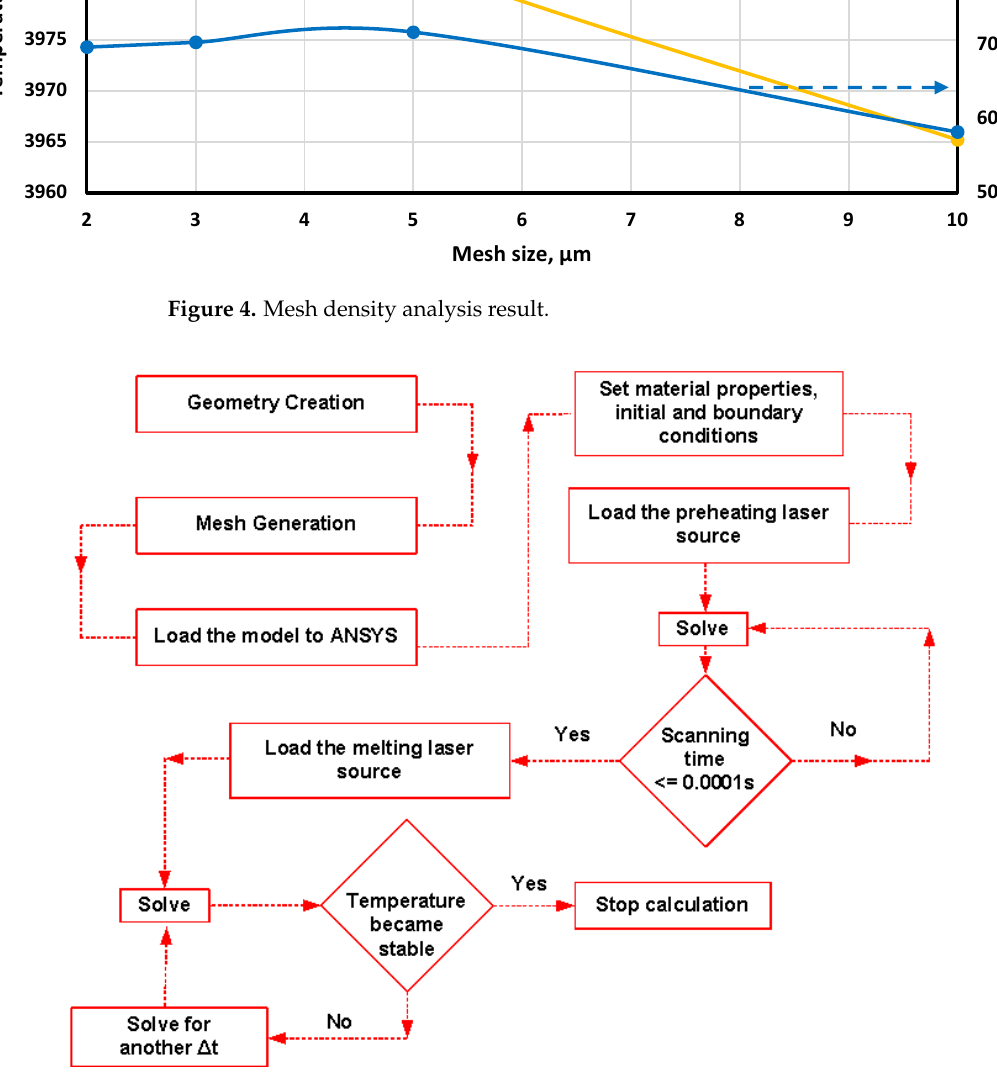
Figure 5. Flowchart of the numerical model solution procedure.